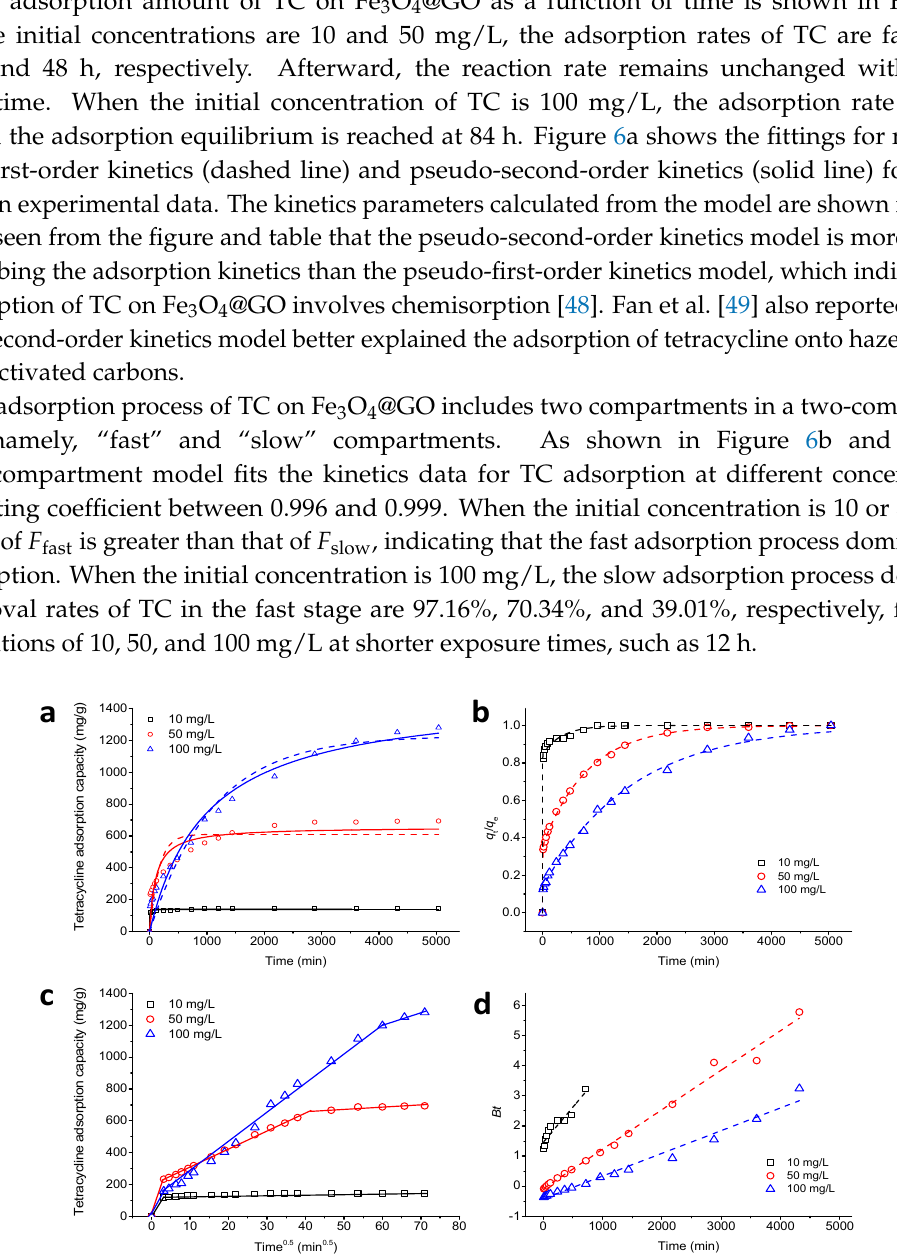
Figure 6. Kinetics of TC adsorption onto Fe 3 O 4 @GO at various TC concentration by fitting ( a ) pseudo-second-order model (dashed lines) and pseudo-second-order model (solid lines), ( b ) two-compartment model, ( c ) intraparticle diffusion model, and ( d ) Boyd model, respectively: pH = 4.0, m / V = 70 g/L, C 0(TC) = 10, 50, and 100 mg/L, T = 303 K.